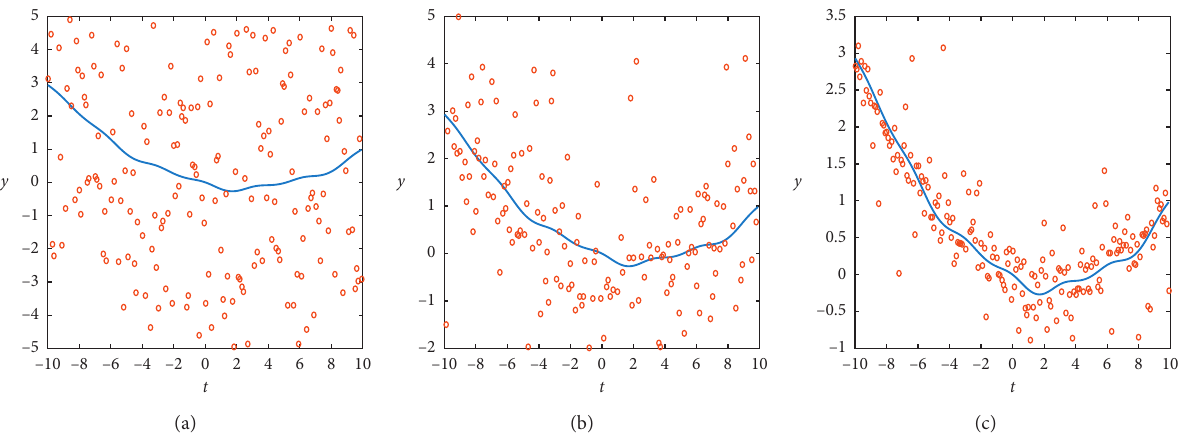
Figure 9: Generated signals for complex model. The curves denote f ( t ; θ ) . The circles denote y ( t ) . (a) Uniform noise. (b) Cauchy noise. (c) Power-law